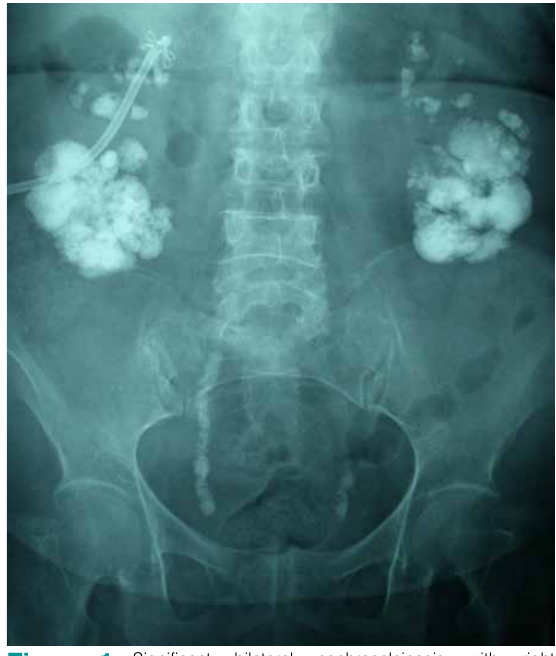
Figure 1. Significant bilateral nephrocalcinosis with right percutaneous